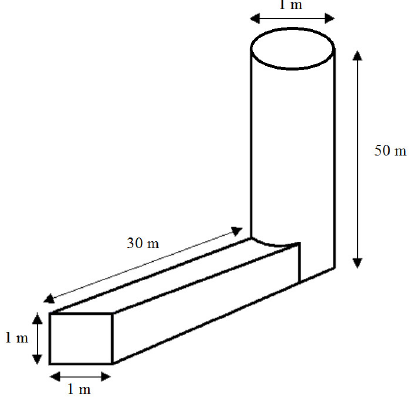
Figure 2. Dimensions of the analyzed solar chimney.